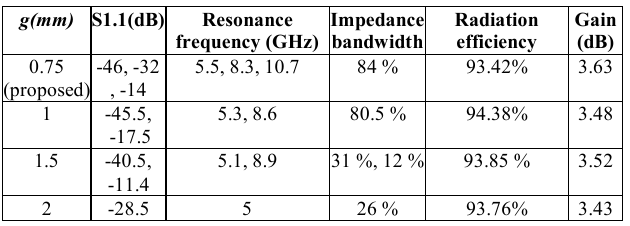
Figure 8: Fabricated prototype of proposed model (a) Top View (b) Bottom View